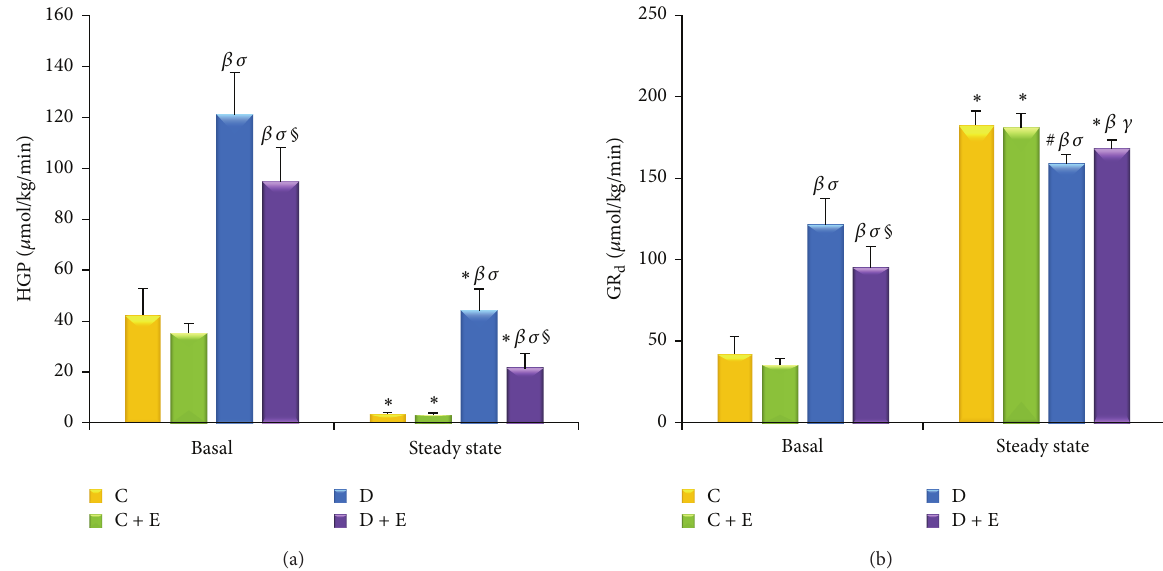
Figure 5: HGP and the disappearance rate of glucose (GR ) during the hyperinsulinemic-euglycemic clamp steady state. HGP following an d overnight fast was higher ( 𝑃 < 0.01 ) in the D group rats than that in the D + E group rats. During clamp steady state, HGP was greater ( 𝑃 < 0.01 ) in the D group rats than that in the D + E group rats (a). In the basal state, the D + E group rats had a lower GR than the C group rats, but this was not significantly different (b). Under the clamp rats ( 𝑃 < 0.01 ). The C + E group rats also had a lower GR d of the D group rats was lower than that of the C group rats ( 𝑃 < 0.05 ) and that of the C + E group rats ( 𝑃 < 0.01 ). The steady state, the GR d of the D + E group rats was also significantly lower than that of the C group rats ( 𝑃 < 0.01 ) and that of the C + E group rats ( 𝑃 < 0.05 ). GR d There was no significant difference found between the C group rats and the C + E group rats ( 𝑃 > 0.05 ) (b). ∗ 𝑃 < 0.01 , # 𝑃 < 0.05 compared with basal. 𝛽 𝑃 < 0.01 , 𝛼 𝑃 < 0.05 compared with C group. 𝜎 𝑃 < 0.01 , 𝛾 𝑃 < 0.05 compared with C + E group. § 𝑃 < 0.01 , 𝜑 𝑃 < 0.05 compared with D